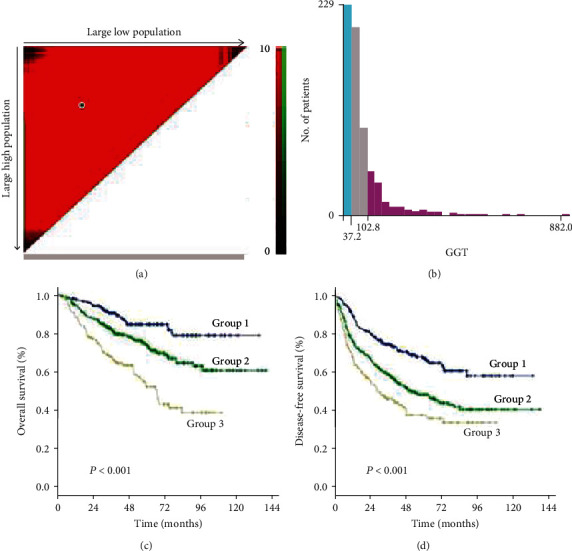
The cutoff points of the preoperative GGT level in AFP-negative HCC patients using X-tile plots. Group 1 was defined as GGT < 37.2 U/L; group 2: GGT ≥ 37.2 and <102.8 U/L; group 3: GGT ≥ 102.8 U/L. (a) The cutoff points are highlighted by black/white circles. (b) The three subgroups are indicated on a histogram including the entire cohort. (c) A Kaplan-Meier curve of overall survival (group 1 vs. group 2 vs. group 3, 58.5 vs. 53.5 vs. 44.4 months, all P < 0.001). (d) A Kaplan-Meier curve of disease-free survival (group 1 vs. group 2 vs. group 3, 47.9 vs. 40.3 vs. 30.1 months, all P < 0.001).